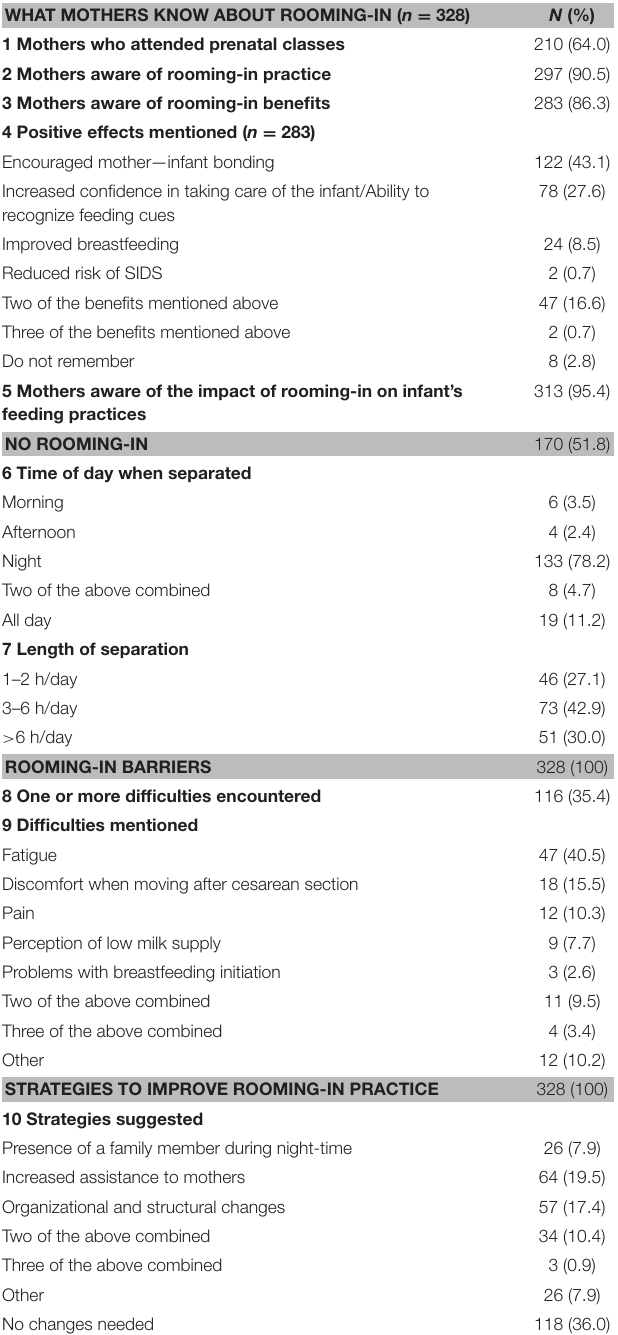
TABLE 3 | Answers to the interview investigating maternal knowledge of rooming-in, barriers, and strategies. WHAT MOTHERS KNOW ABOUT ROOMING-IN ( n =